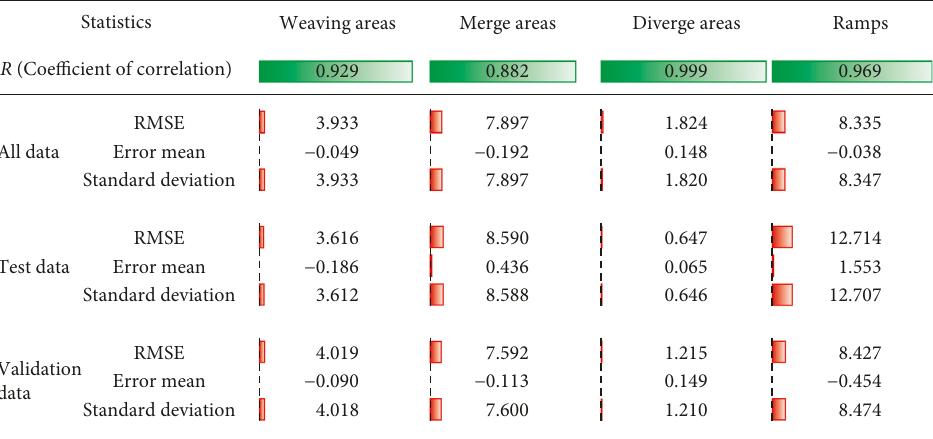
Figure 11: Statistical results of using the ANN-based model.